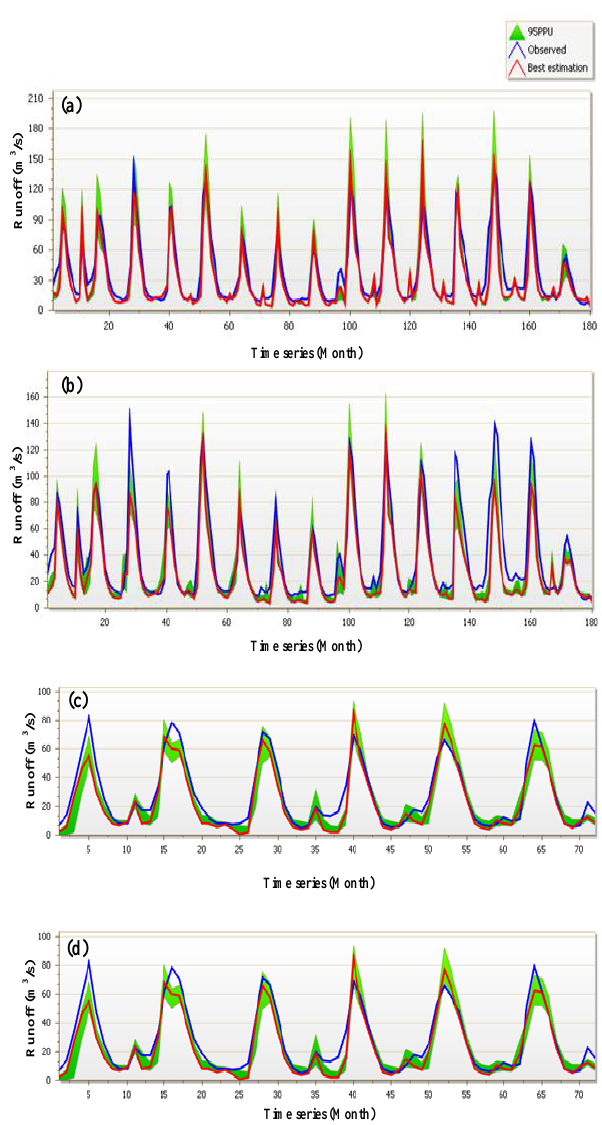
Figure 4. Discharge calibration results for the period of 1994– 2008 using (a) GRGs dataset and (b) SPPs dataset. Discharge validation results for the period of 2009–2015 using (c) GRGs dataset and (d) SPPs dataset.